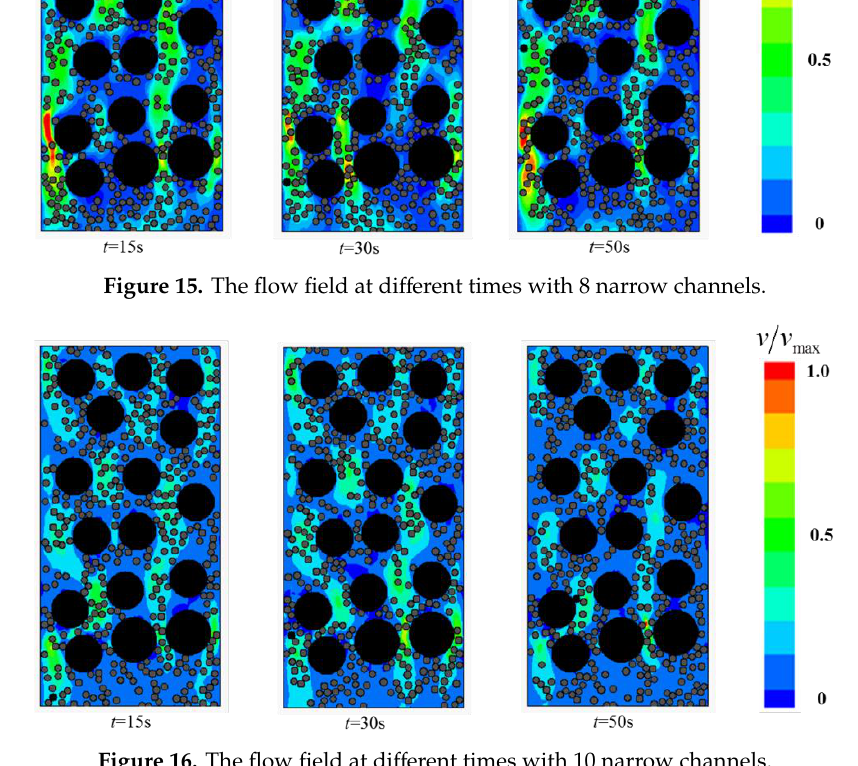
Figure 16. The flow field at different times with 10 narrow channels.